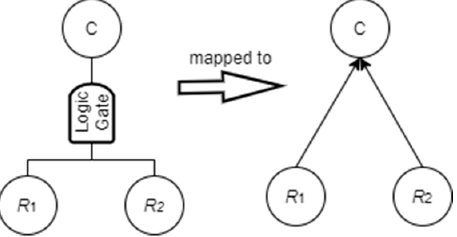
Figure 3. Illustration of mapping a logic gate to BN model.